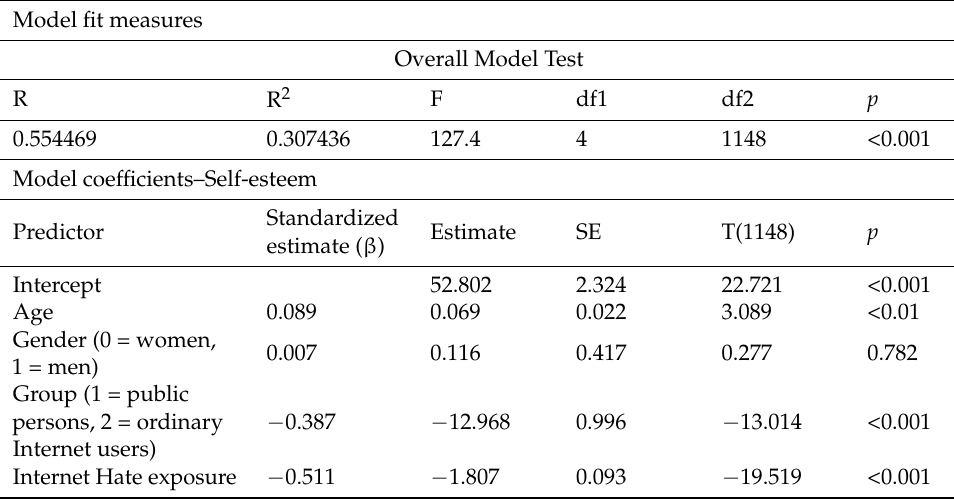
Table 5. Regression model predicting higher Self-esteem ( n = 1153).